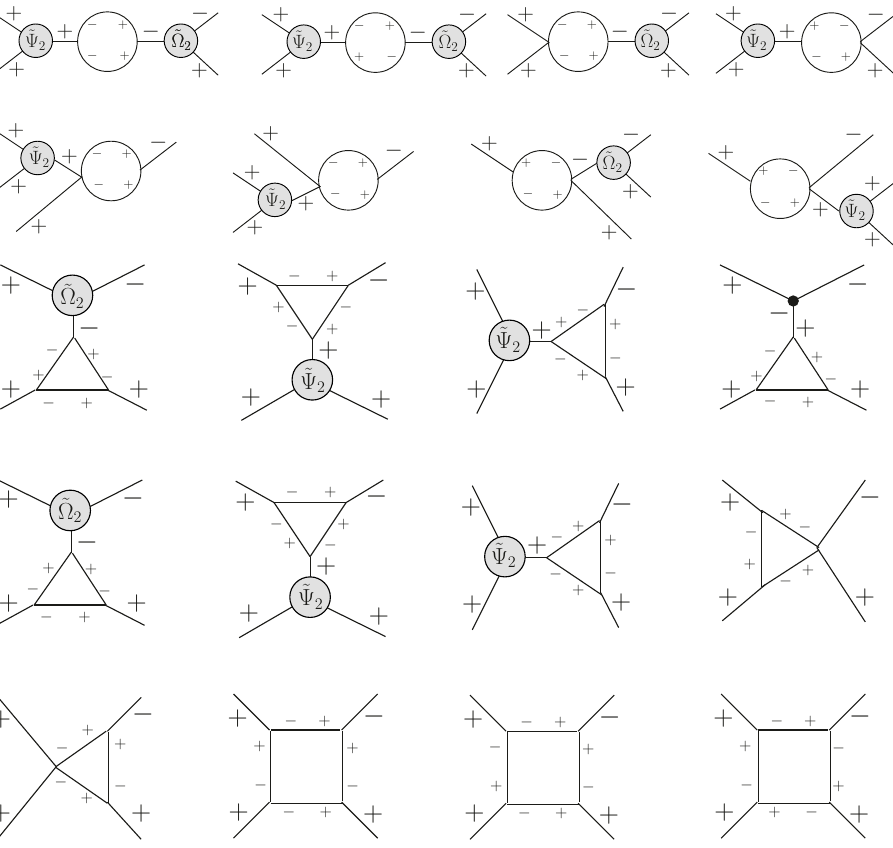
Figure 11 . The contributions to (+++ − ) one-loop amplitude originating from (3.22) via the rules discussed in appendix A. For simplicity we suppressed the symmetry factors and the line momenta associated with each term. The kernels ˜Ψ and ˜Ω result from the substitution of inverse Wilson 2 2 line eq. (3.12)–(3.13). The • in the last term of line 3 represents the (+ −− ) three point MHV vertex connected with the ∆ +++ via a